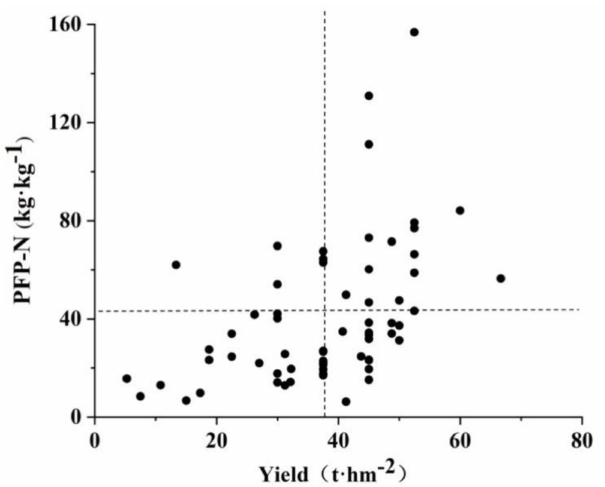
Figure 2. Distribution of the surveyed smallholders as per yield and partial productivity of the fertilizer (PFP-N). The dotted line in the figure represents the average yield and PFP-N. In the planting stage, average apple yield of HYHE farmers was 50.3 t · hm − 2 , PFP- N was 29.3 kg · kg − 1 , and the economic benefit was 78,262.5 184 CNY · hm − 2 , and the N footprint was 3.06 kg · kg − 1 , which were 33.4%,61.2% and 48.8% higher than those of TPs. The N footprint was 3.06 kg · kg − 1 , which was 67.6% lower than the average TP level (Figure